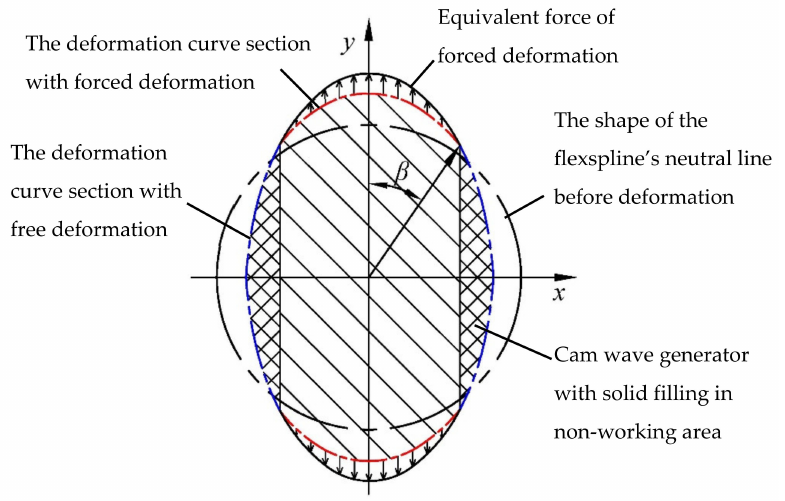
Figure 3. New deformation model of the